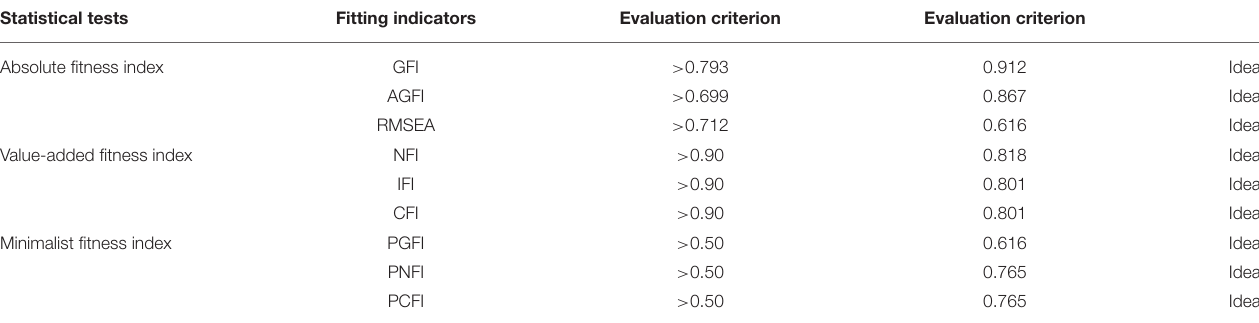
TABLE 4 | Model fitting index